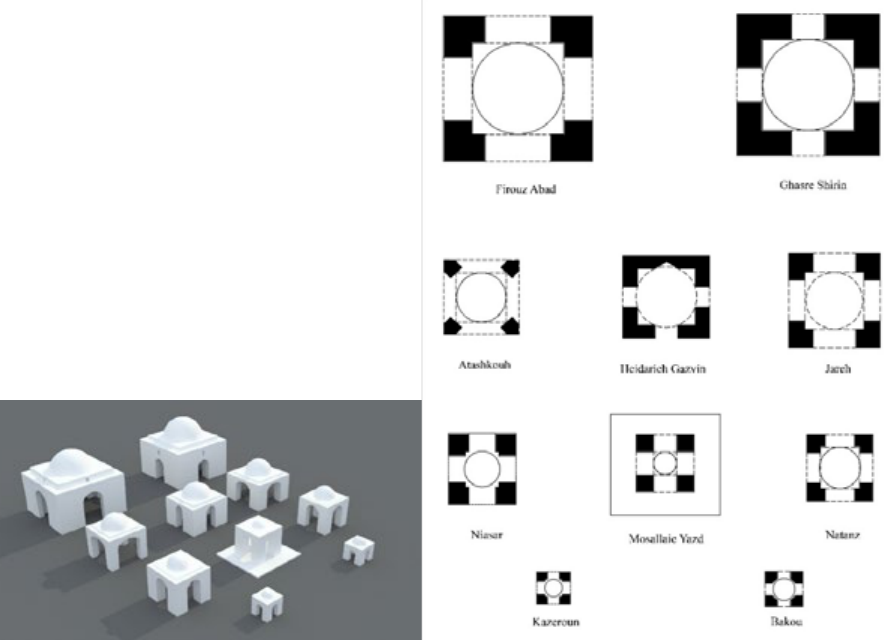
Fig. 1: Explored square domes in Iran Fig. 1. Explored square domes in